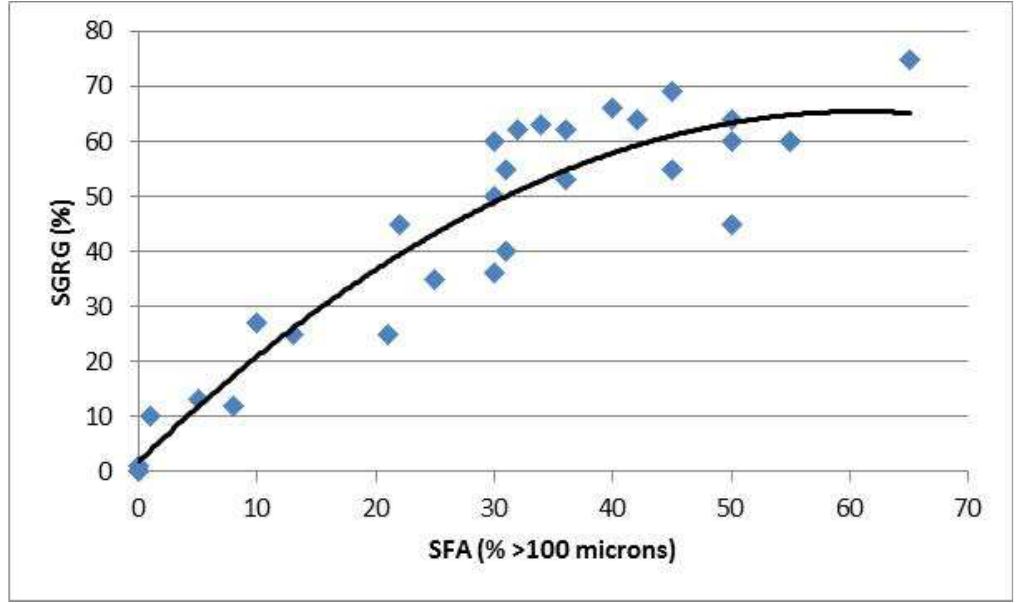
Figure 4. Relationship between single-stage GRG (SGRG) and screen fire assay (SFA) coarse gold values in the SVZ.